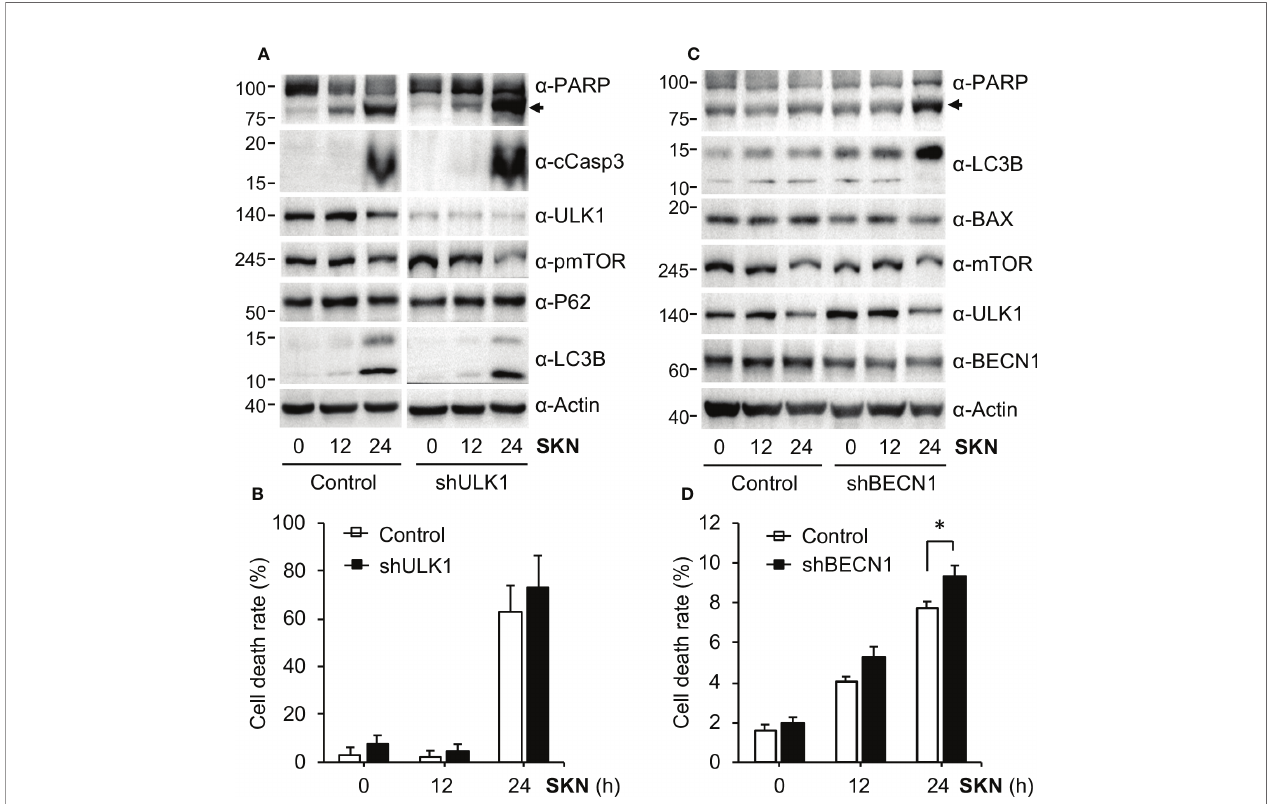
FIGURE 6 | Shikonin activated autophagy. (A) A549 control or ULK1 depleted cells were treated with 5 m M of Shikonin for 0, 12 and 24 h, and protein expression was measured. (B) Quantitation of dead cell population from (A) by trypan blue staining. Data represent mean and standard deviation from fi ve replicates. (C) HeLa control or BECN1 stably depleted cells were treated with 5 m M of Shikonin for 0, 12 and 24 h, and protein expression was measured using speci fi c antibodies. (D) Quantitation of dead cell population from C by trypan blue staining. Data represent mean and standard deviation from fi ve replicates. *P <